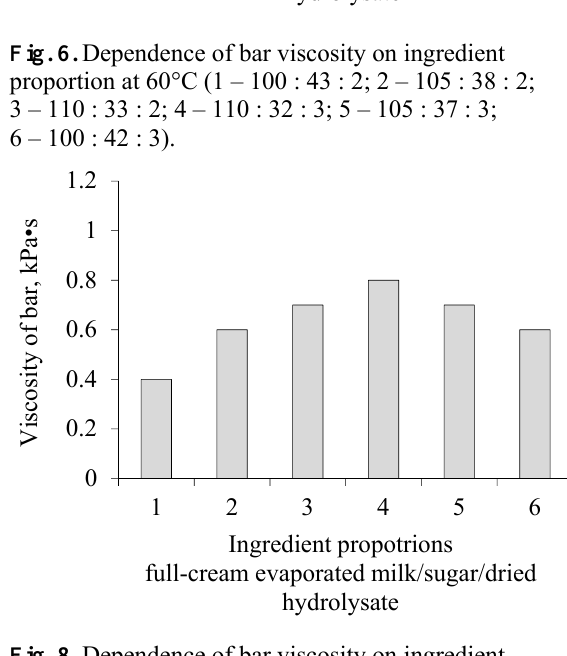
Fig. 7. Dependence of bar viscosity on ingredient Fig. 8. Dependence of bar viscosity on